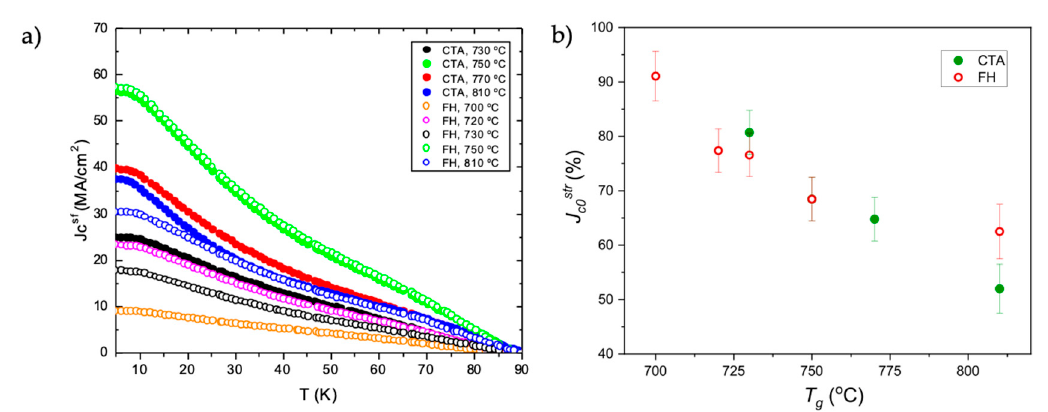
Figure 8. ( a ) Self-field critical current density J c values as a function of the temperature for samples grown with the CTA method (closed symbols) and the FH method (open symbols) ( b ) Percentage of strong pinning contribution to J c at 0 K, determined by fitting the J c ( T ) curves shown in ( a ) with Equations (1) and (2).